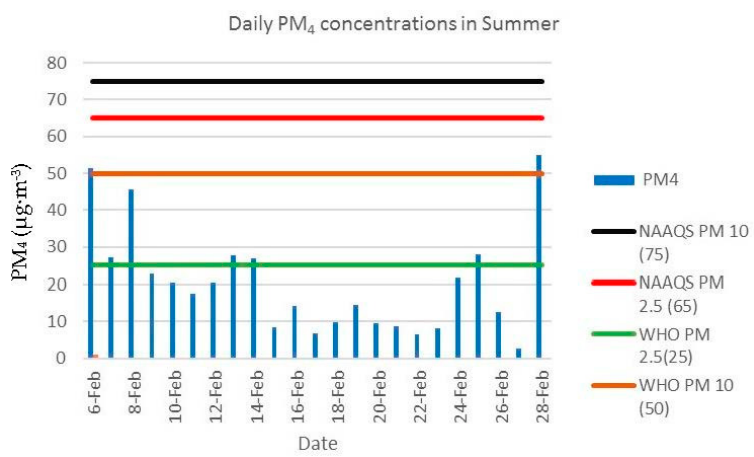
Figure 4. Indoor kitchen PM 4 concentrations measured in summer compared to NAAQS standards and WHO guidelines.